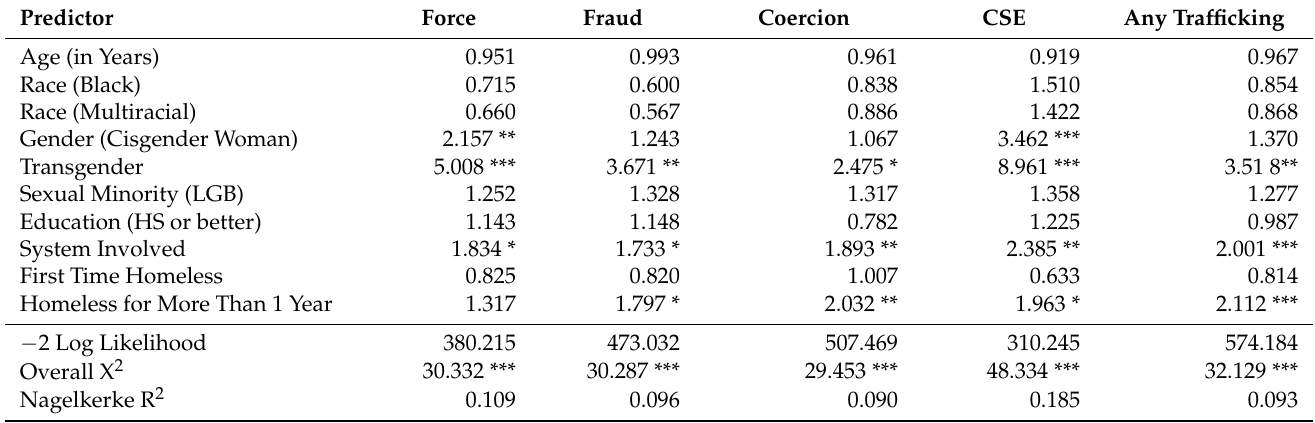
Table 6. Logistic Regression analyses of each type of and any trafficking experienced while homeless among youth experiencing homelessness, 2018 Atlanta Youth Count (n =